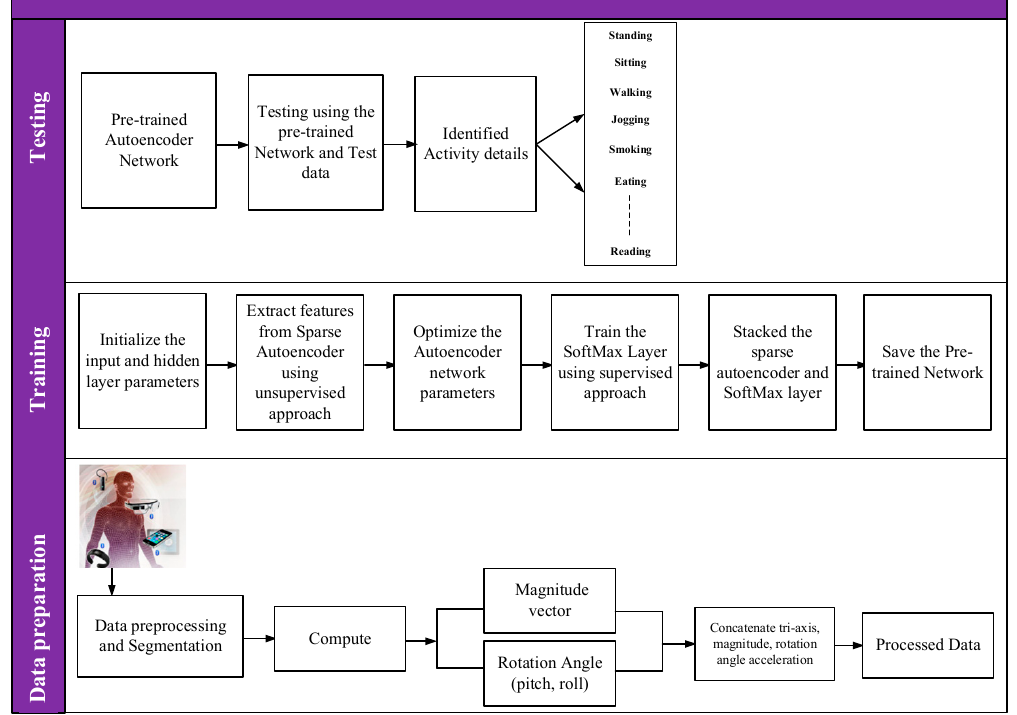
Figure 1. Proposed complex human activity identification framework.